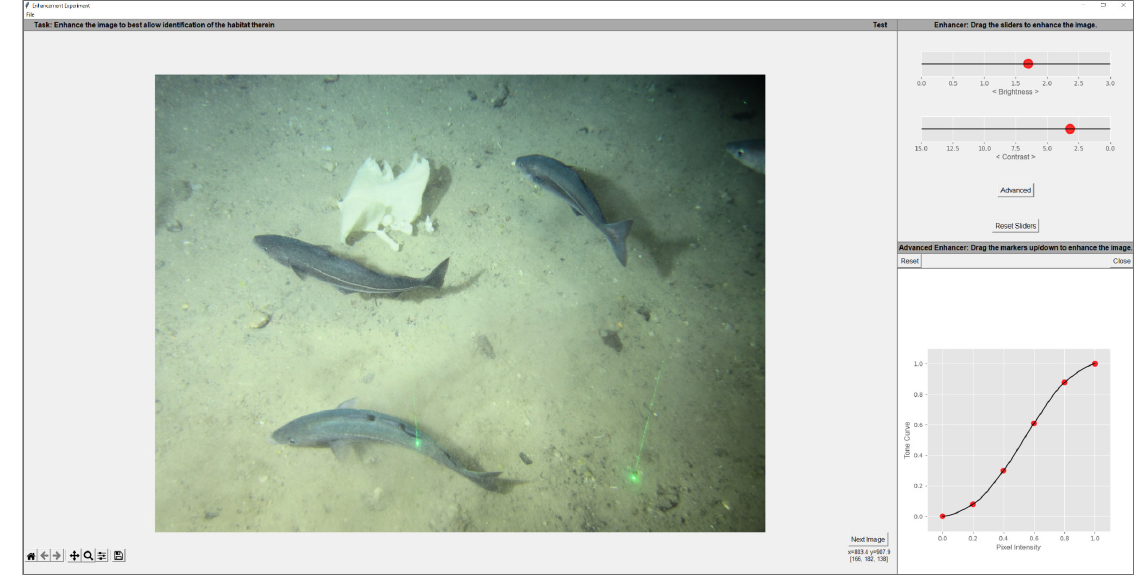
Figure 9. Experiment GUI.